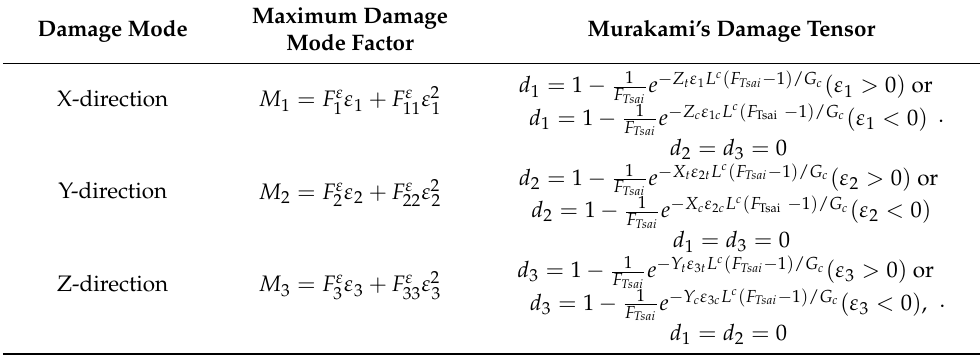
Table 1. Damage model of the satin weave